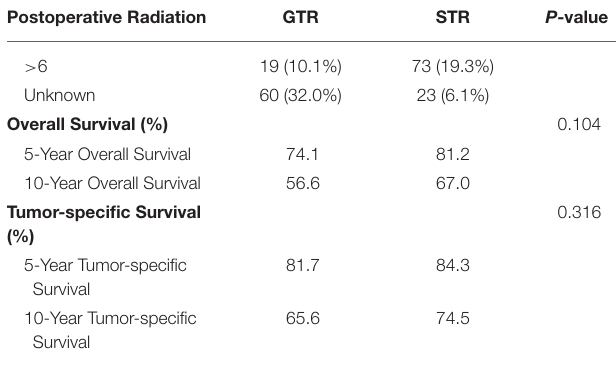
Survival Analysis and Prognostic Factor Identification Survival analysis based on univariate and multivariate Cox analyses was performed on all selected patients. The results showed that age at diagnosis, primary site, disease stage, tumor size, and whether or not undergo surgery were closely related to the prognosis of primary skull base chordoma ( p < 0.05), as shown in Table 2 . Multivariate analyses demonstrated that age